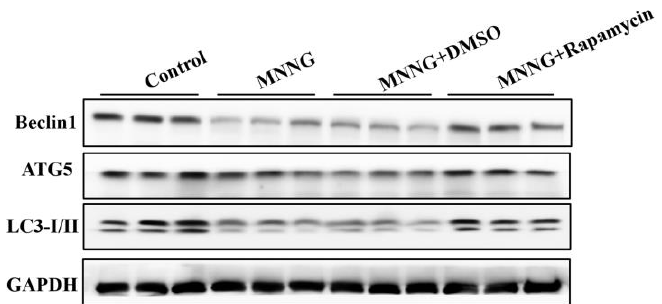
Figure 3. MMNG-mediated autophagy was recovered by rapamycin in the gastric tissues of rats. Rats were divided into a control group, an MNNG group, an MNNG and DMSO group, and an MNNG and rapamycin group. Western blot showed that rapamycin reversed the downregulation of Beclin1, LC3-I/II, and ATG5 induced by long-term MNNG exposure. Tissues were from n = 3 rats as representative images.